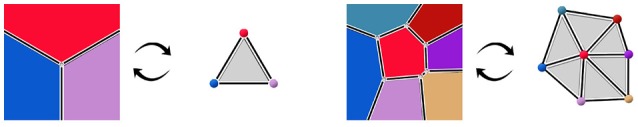
Dualization of cellular complexes representing cells the geometry of tissue cells into simplicial complexes representing their adjacency.